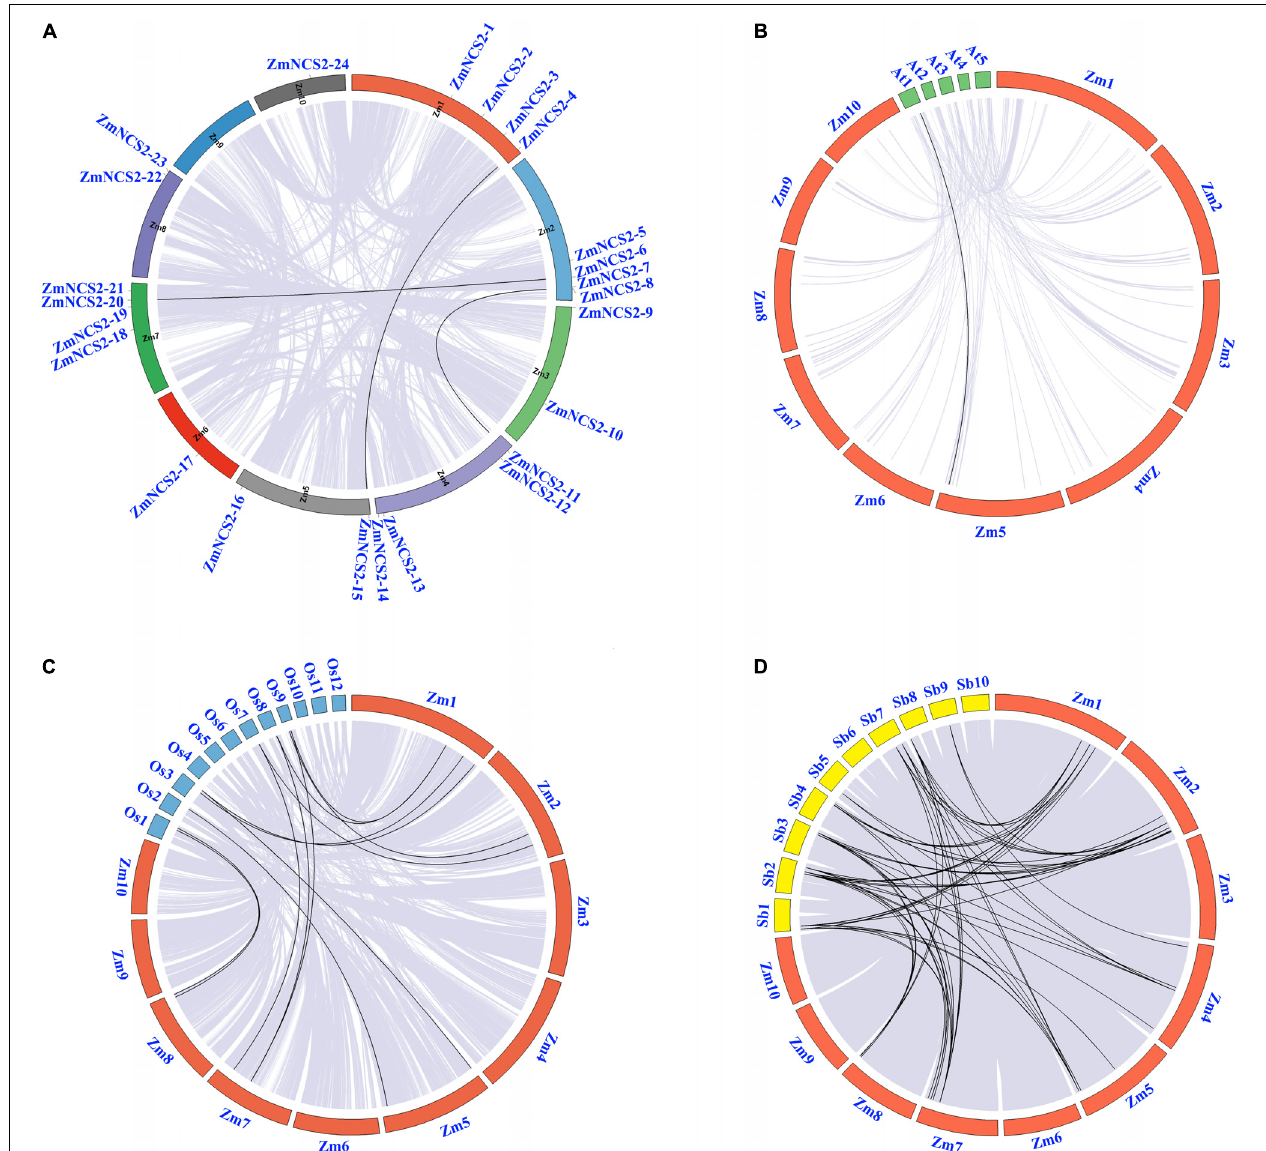
FIGURE 2 | Microsyntenic relationships among the NCS2 regions in Zea mays , Sorghum bicolor , and Oryza sativa . (A) Chromosomal locations of ZmNCS2 genes and WGD paralogous genes in maize. (B–D) Zea mays (Zm), Sorghum bicolor (Sb), and Oryza sativa (Os) chromosomes are presented in different colors. Black lines represent syntenic relationships between NCS2